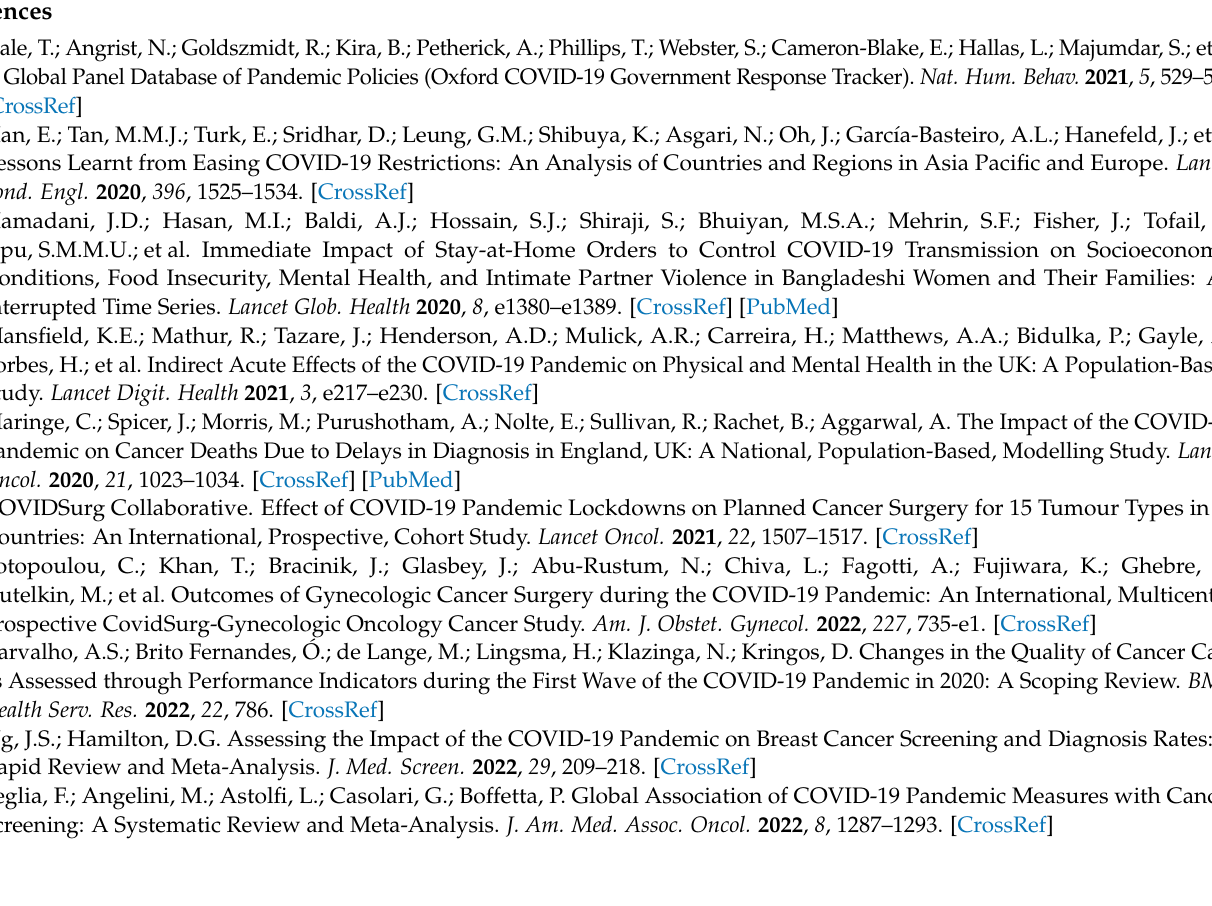
Figure S2: “Difference actual vs. forecasted [RSV]”, Table S1: “Checklist for Documentation of